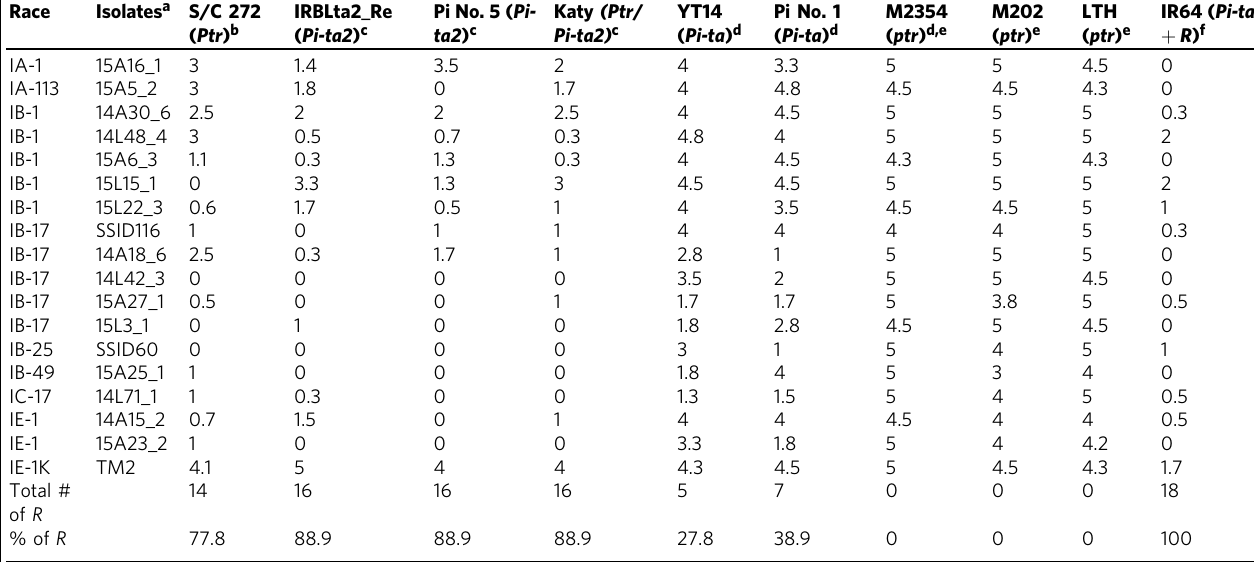
Table 1 Ptr without Pi-ta confers similar blast resistance spectra to that of Pi-ta2 Race Isolates a S/C